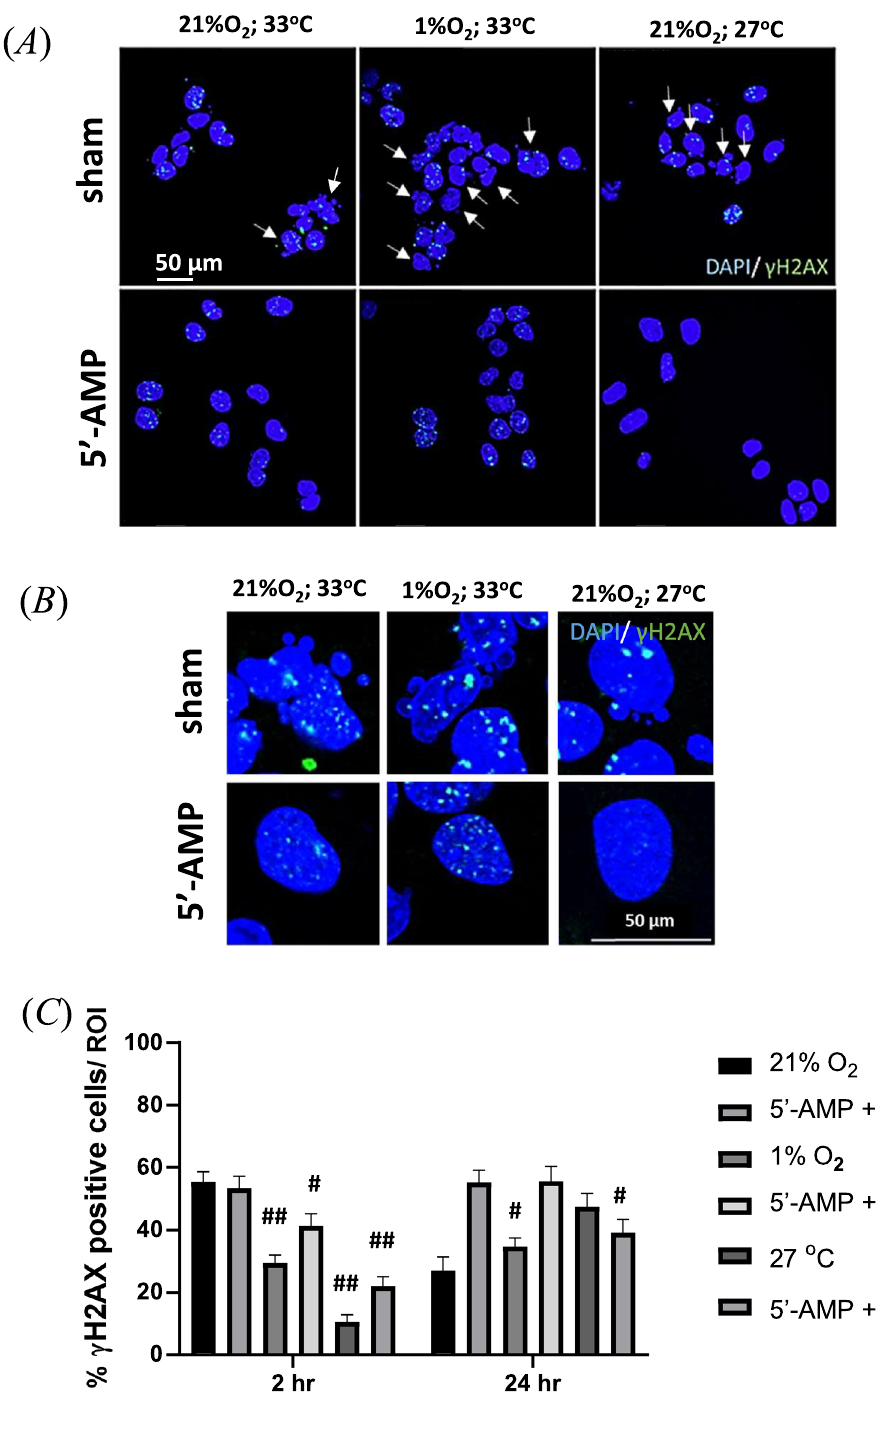
Figure 5. The 5 ′ -AMP delays the radiation-induced DNA repair and decreases the mitotic catastrophe after irradiation in RPE-J cells. ( A ) Representative images of γH2AX foci (green) positive cells inside the nucleus (DAPI, blue). The irradiated cells without 5 ′ -AMP showed irregular nuclei (arrow point). ( B ) In the magnifying images of nuclei morphology, the sham cells showed catastrophic mitotic features. ( C ) The percentage γH2AX positive nuclei. A significant decrease up to 30 to 40% of γH2AX positive nuclei (< 10 foci) observed on cells kept in a hypoxic even lower number on low temperature, less than 20% with and without 5 ′ -AMP treatment. Twenty-four hours after irradiation, the γH2AX positive nuclei (< 10 foci) showed a reduction to 30% in normoxic conditions without 5 ′ -AMP. The cells that were maintained in hypoxia before are comparable to normoxic cells. The cells were kept in the low-temperature condition before showing higher positive nuclei than 2 h results. Data are presented as the mean SEM. # P < 0.001; ## p < 0.0001. Images were obtained from 10 to 25 random ROIs (two coverslips from each